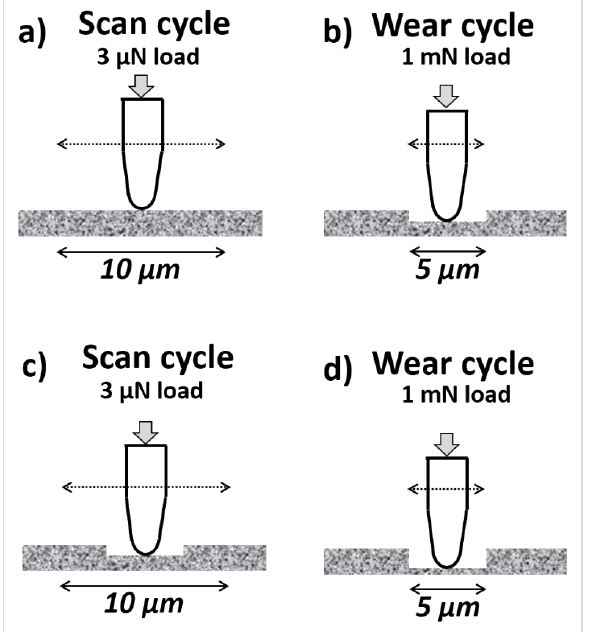
Figure 2: Schematics of the used scratch method to measure friction and wear: (a) pre-scan to get the initial topographical profile; (b) first cycle of wear; (c) post-scan to get the new topographical profile; (d) three cycles of wear. The processes (c) and (d) are repeated ten times. Reprinted with permission from [13], copyright 2015 AIP Publishing LLC.